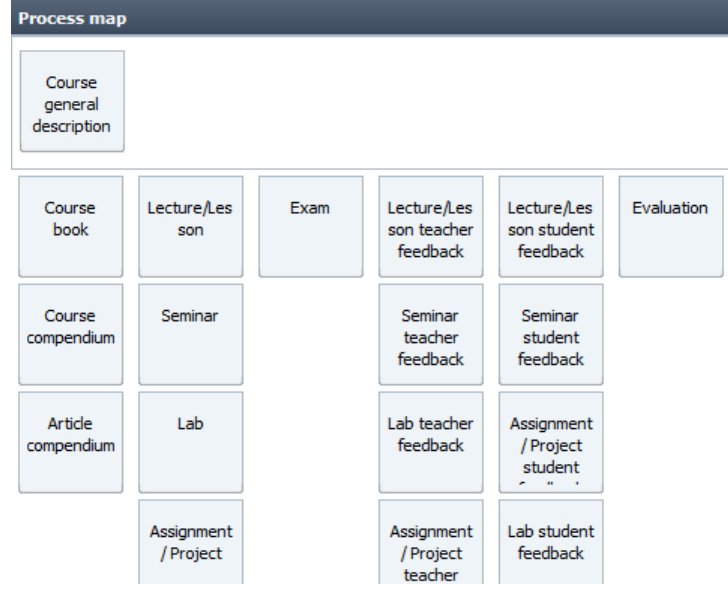
Figure A2. A process